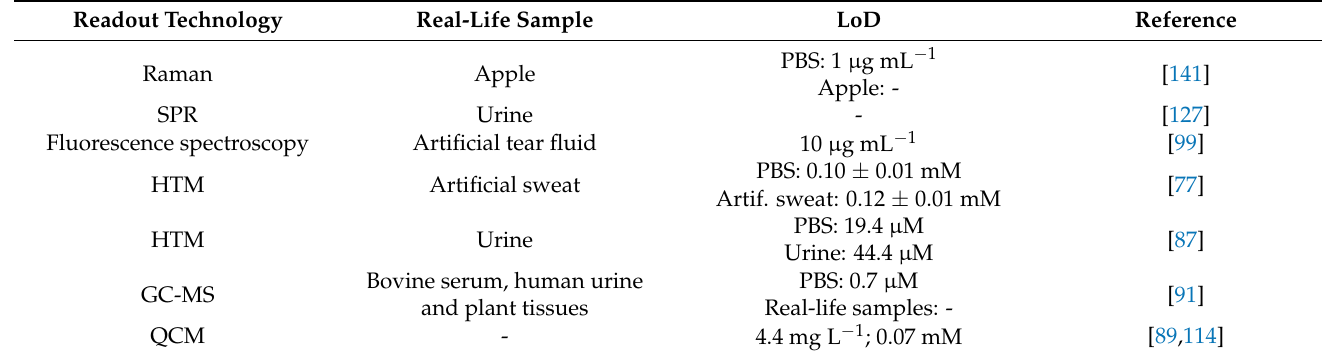
Table 3. MIP-based sensors coupled with non-electrochemical readout